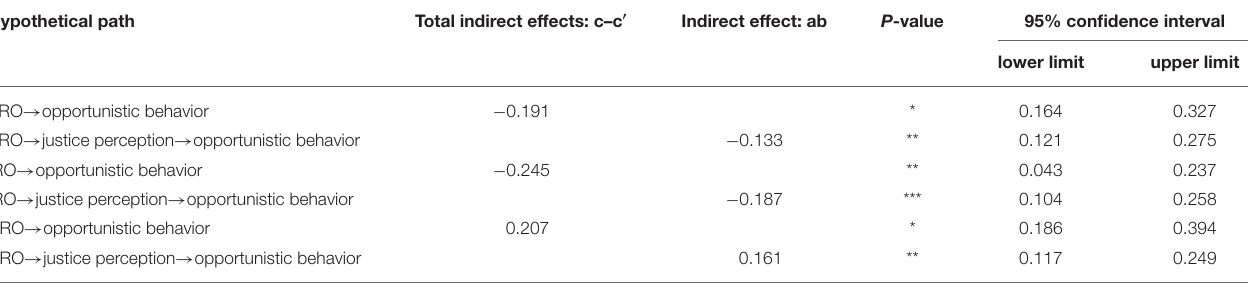
TABLE 6 | Test results of mediating